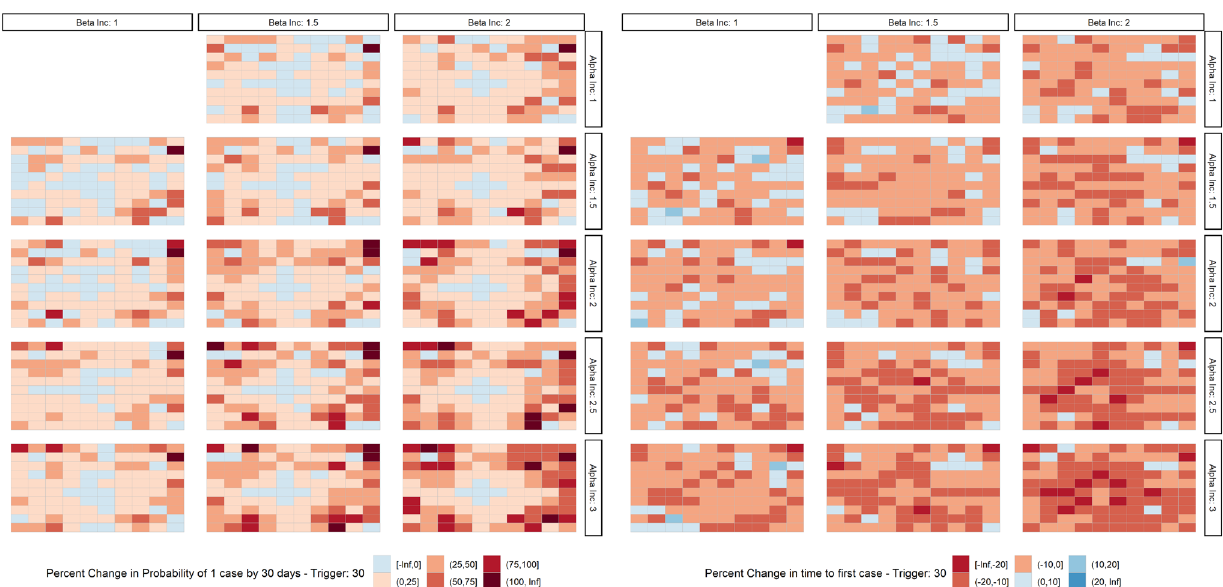
Figure 6. Percent change in probability of having at least 1 case by 30 days (left); Percent change in the number of days till the first case